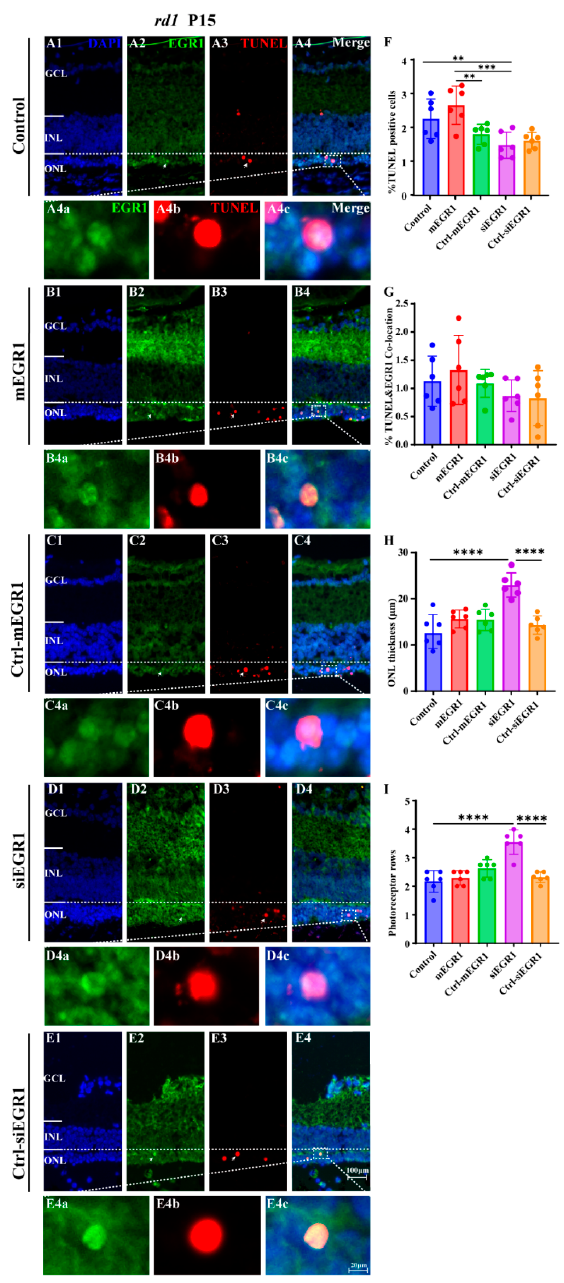
treatment with a control construct for siRNA EGR1. The arrows indicate the colocalization cells of EGR1 and PARP1 positive cells. The colocalized sections (merge, A4c , B4c , C4c , D4c , E4c ) show the expression of EGR1 (green, A4a , B4a , C4a , D4a , E4a ) and PARP1 (red, A4b , B4b , C4b , D4b , E4b ), and nuclei were counterstained with DAPI (blue). ( F – H ) Quantification of ( F ) percentage of EGR1 positive cells in rd1 outer nuclear layer (ONL), ( G ) percent PARP1-positive cells in ONL, ( H ) percentage of ONL cells displaying colocalization of EGR1 and PARP1 staining. Images shown are representative of observations for at least six different specimens of each genotype. Error bars represent SD. INL = inner nuclear layer, GCL = ganglion cell layer. Scale bar = 100 µ m (20 µ m in insert). * = p < 0.05.